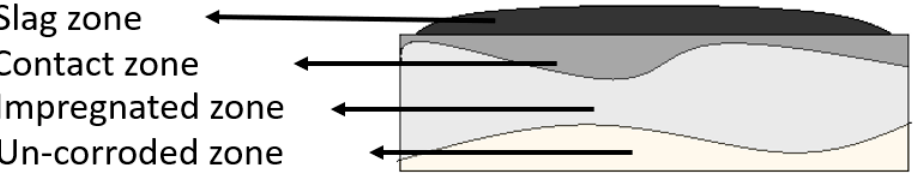
Figure 1. The schema of different corrosion zones in a contact corrosion test.